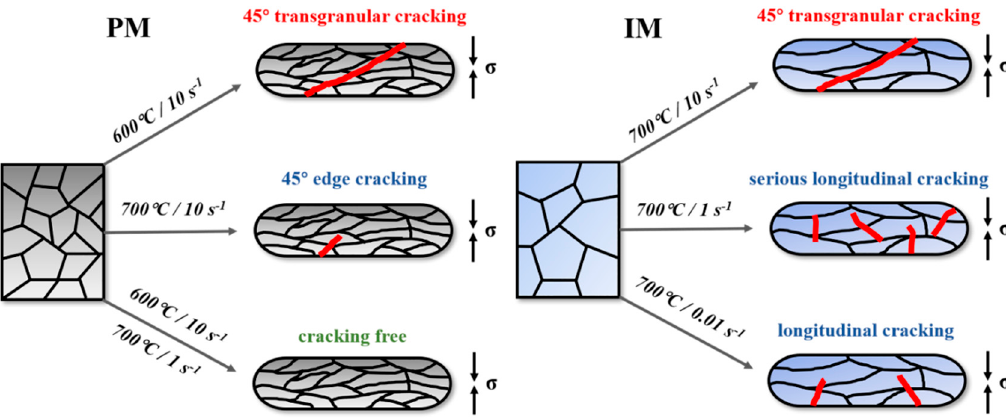
Figure 12. Schematic illustration of the cracking modes of the PM and the IM Ti-5553 alloys.